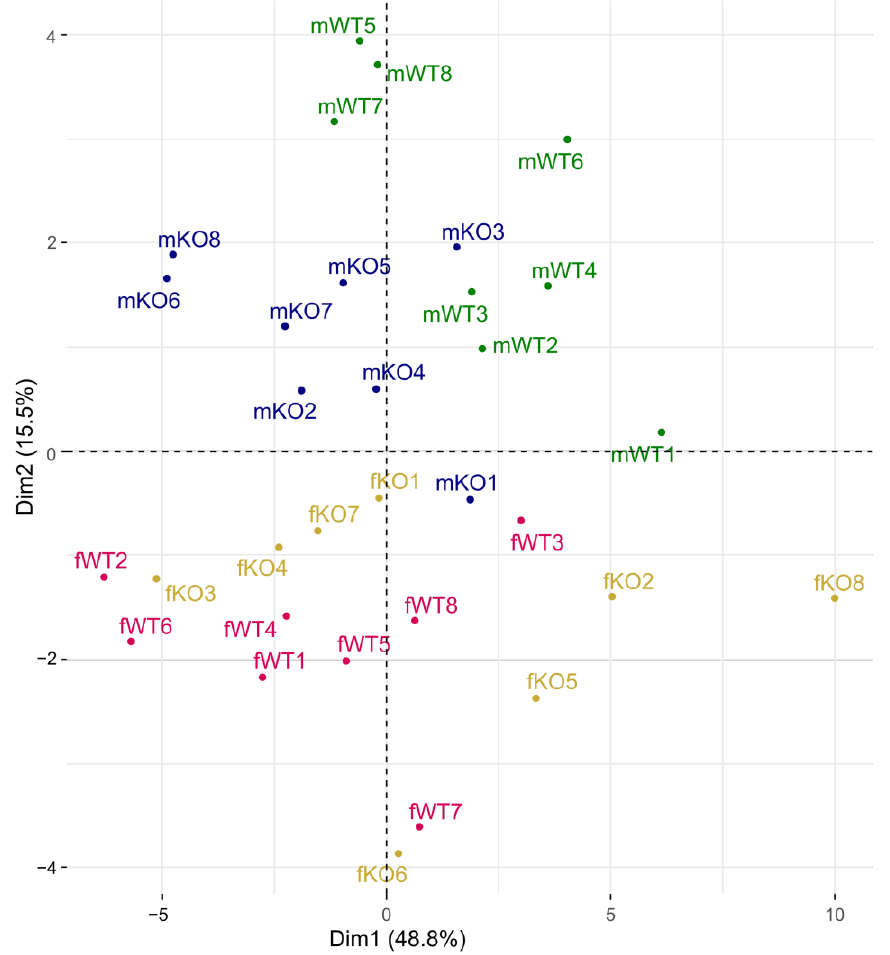
Figure 3. Score plot showing individual animals in a principal component analysis (PCA), where genotype and plasma levels of amino acids were of interest. Blood was collected from adult mice and the plasma was used for amino acid quantification. Amino acid levels were determined by LC-ESI-MSMS and used in a PCA to visualize groupings between sex and genotype. fKO, female knockout mouse; fWT, female wildtype mouse; mKO, male knockout mouse; mWT, male wildtype mouse. Numbers separating individuals within each grouping.